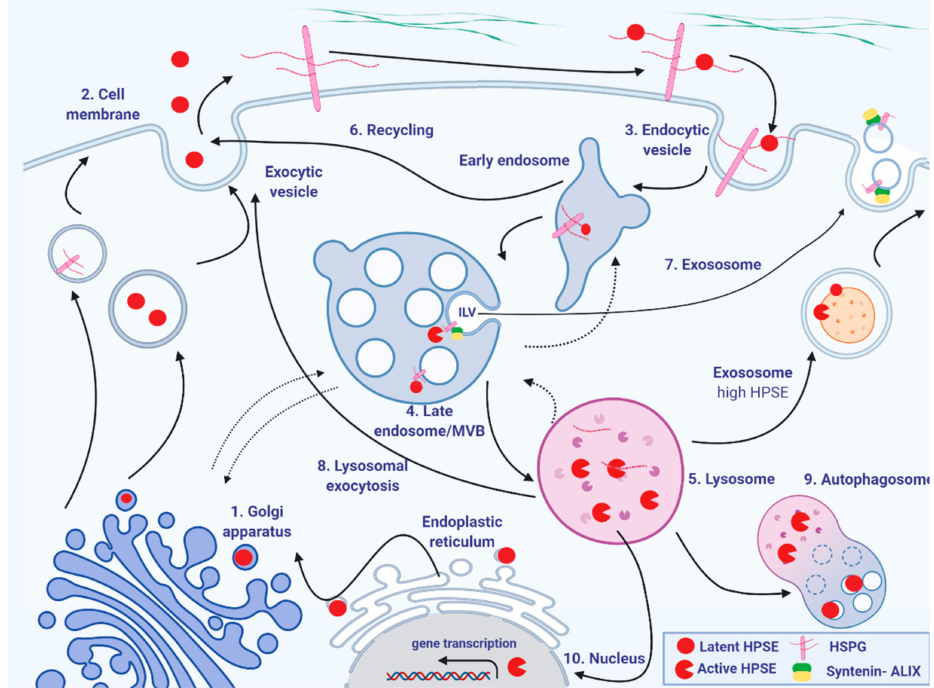
Figure 1. Schematic model of heparan sulfate proteoglycans and heparanase tra ffi cking. (1) In the Golgi apparatus HS chains are polymerized and preHPSE is processed to produce proHPSE by